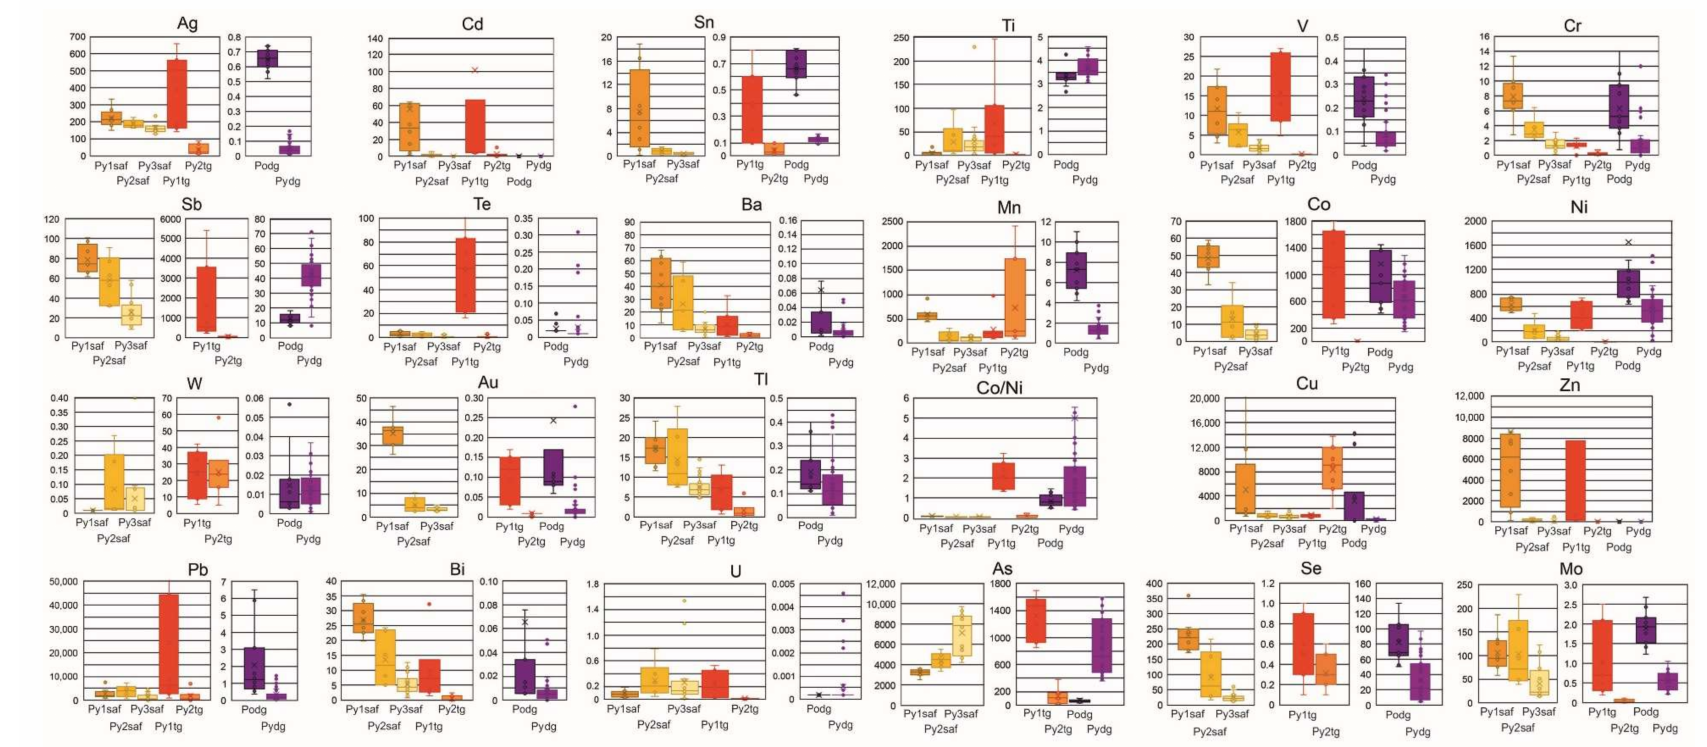
Figure 6. Box-and-whisker plots for trace elements in sulfides of nodules from sulfide–black shale diagenites of the Saf’yanovskoe deposit, sulfide–carbonate–hyaloclastite diagenites of the Talgan deposit, and sulfide–serpentinite diagenites of the Dergamysh